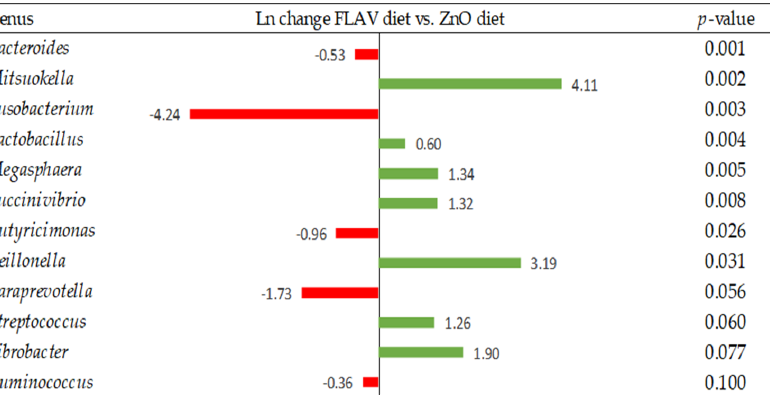
Figure 7. Differentially abundant taxa (Ln change) between diets supplemented with the flavonoid compound (FLAV) and the control diet (CON). Positive values (green color) and negative values (red color) indicate greater and lower abundance, respectively. Taxa are sorted by level of signifi- cance (from higher to lower). Only significant taxa are presented ( p- value < 0.10). Data are means of